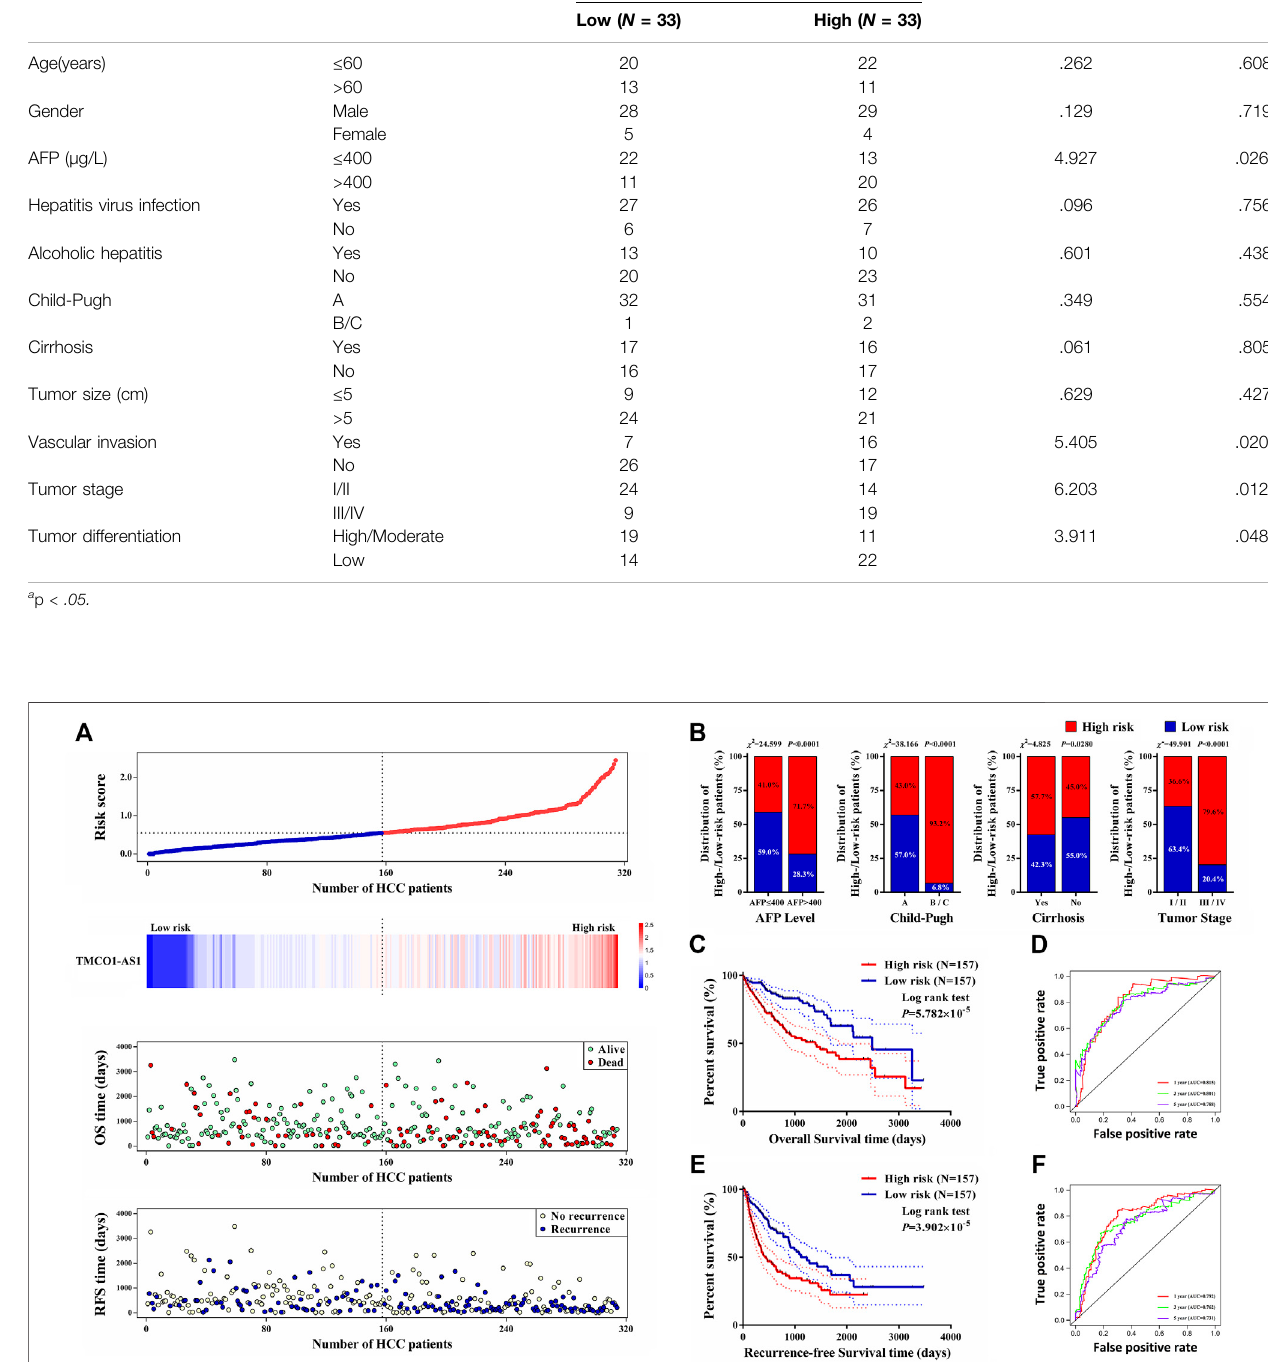
TABLE 2 | Relationship between the expression levels of TMCO1-AS1 and clinicopathological characteristics in 66 HCC patients from our center. Clinicopathological characteristics